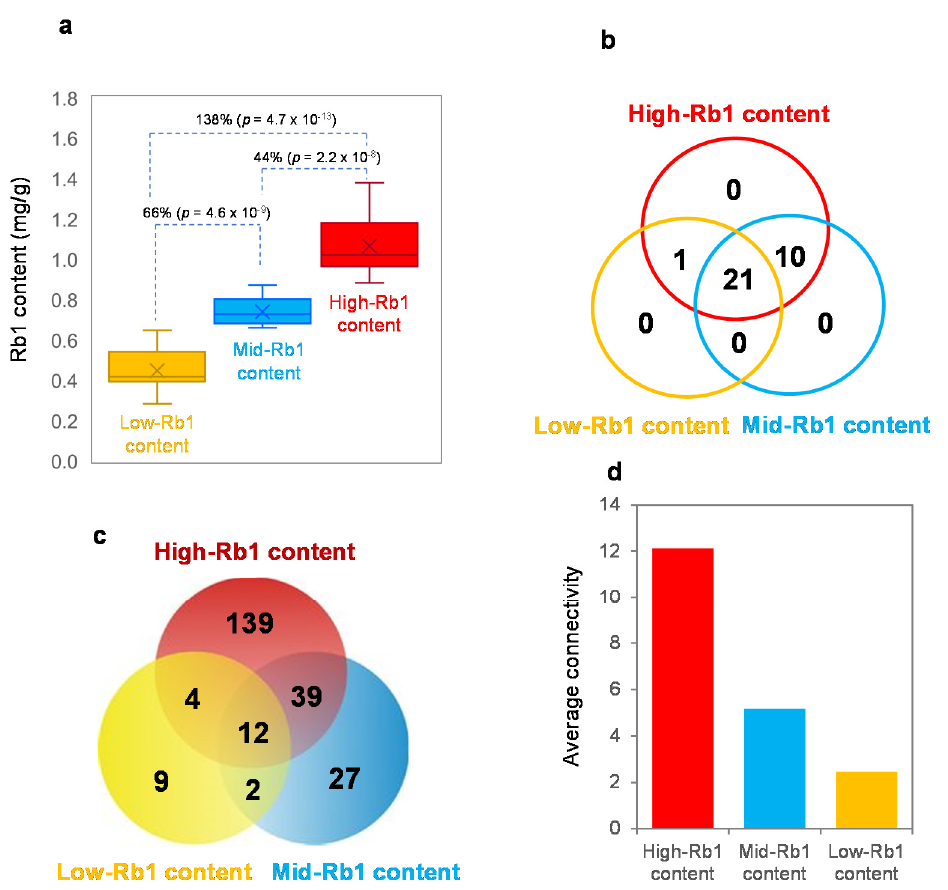
Figure 6. Impact of the Rb1 biosynthesis gene network variation on Rb1 biosynthesis. ( a ) Variation of Rb1 contents among cultivars. ( b ) Impact of variation of the gene nodes in the network on Rb1 biosynthesis. ( c ) Impact of variation of the gene interaction edges in the network on Rb1 biosynthesis. ( d ) Impact of variation of the network robustness, presented by average connectivity, on Rb1 biosynthesis.